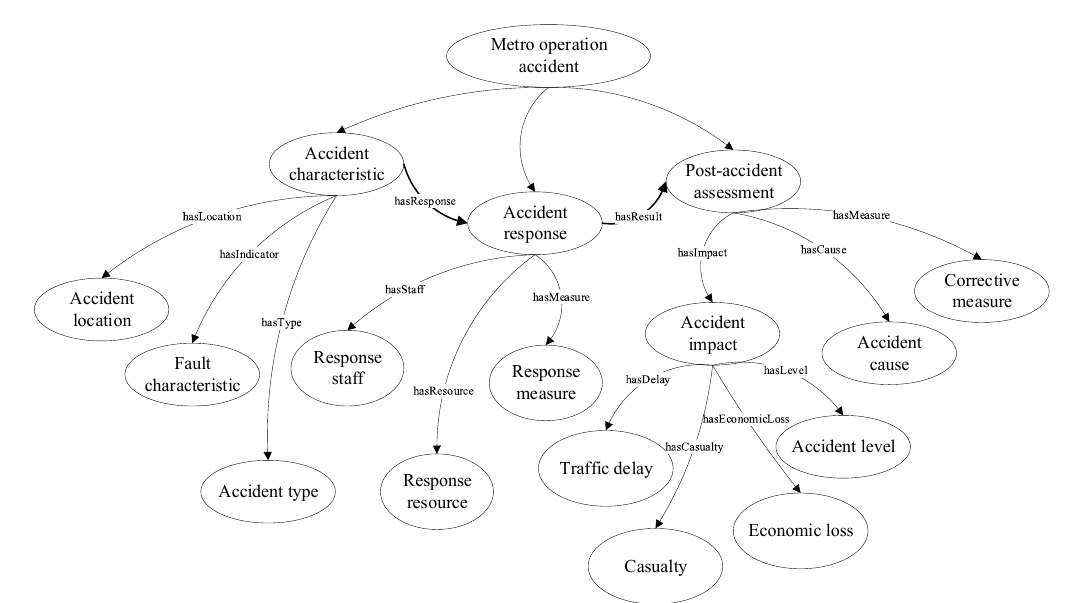
Figure 3. The top-level ontological model for metro accidents.